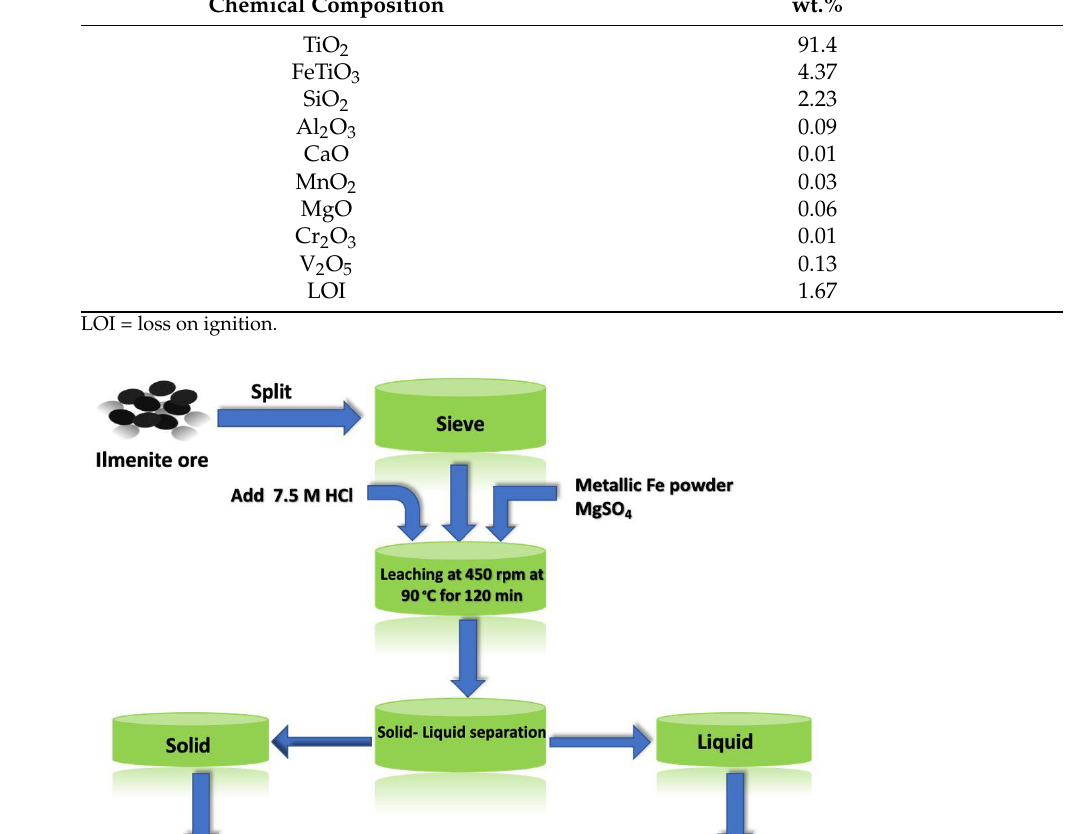
Figure 15. XRD pattern of the leached residue under optimum leaching conditions. Table 5. Chemical composition (wt.%) of the leached residue obtained by XRF. Chemical Composition